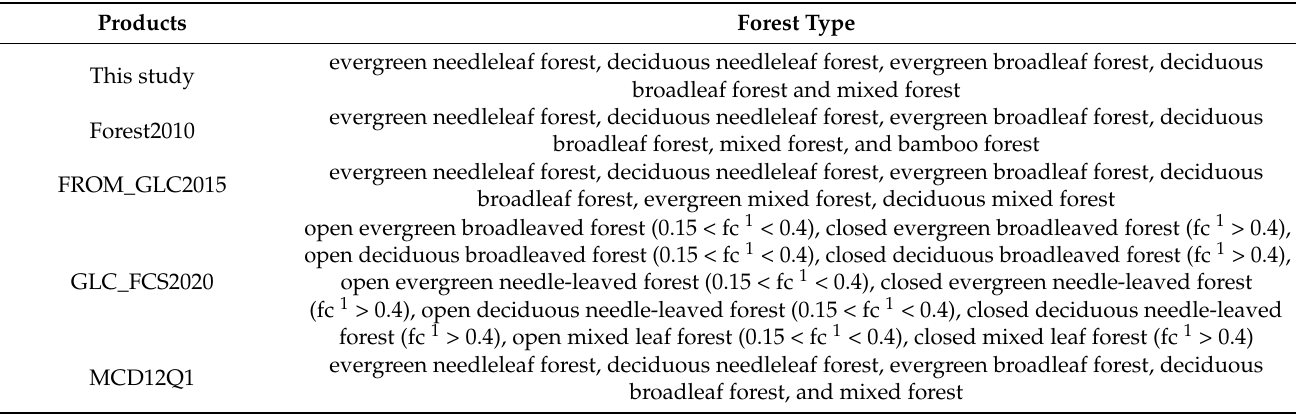
Table 7. Forest type comparison of different